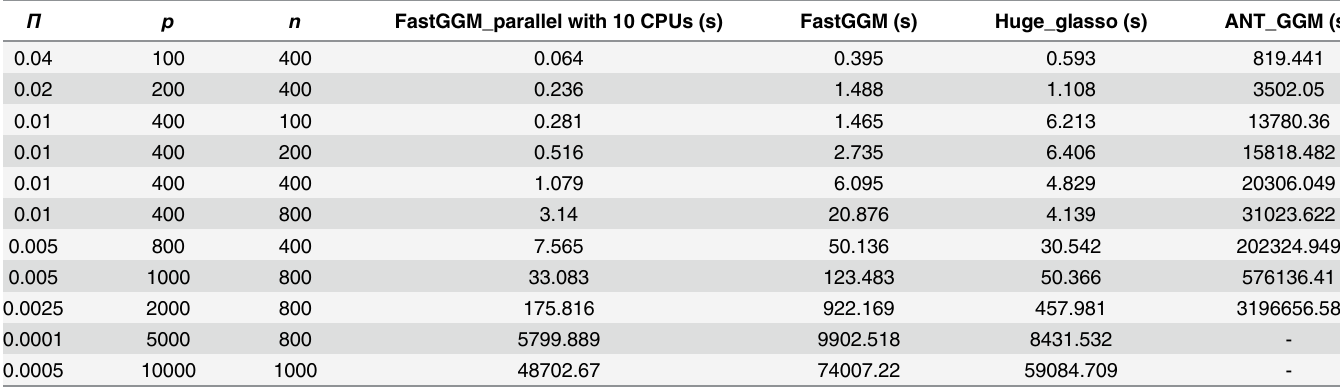
Table 2. Comparison of computational